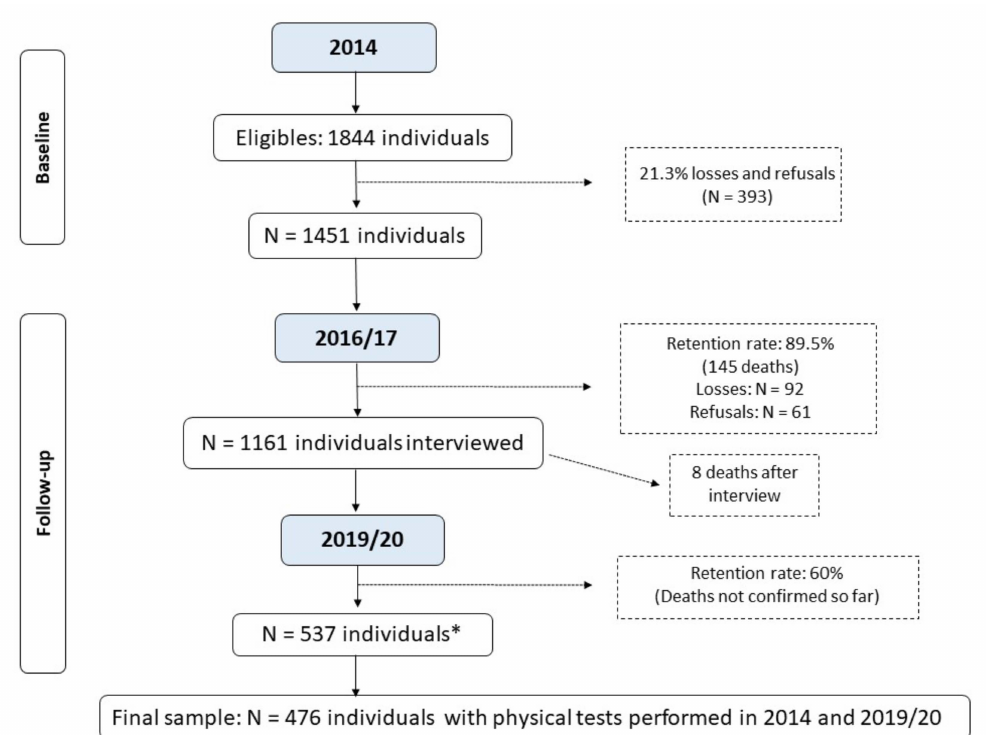
Figure 1. Flowchart of the Longitudinal Study of Older Adults Health: continuing the “COMO VAI?” study. * Number of living older adults located and interviewed before the study was interrupted due to the COVID-19 pandemic; the deaths that occurred until December/2022 were not yet verified by the epidemiological surveillance of Pelotas due to the duration of the